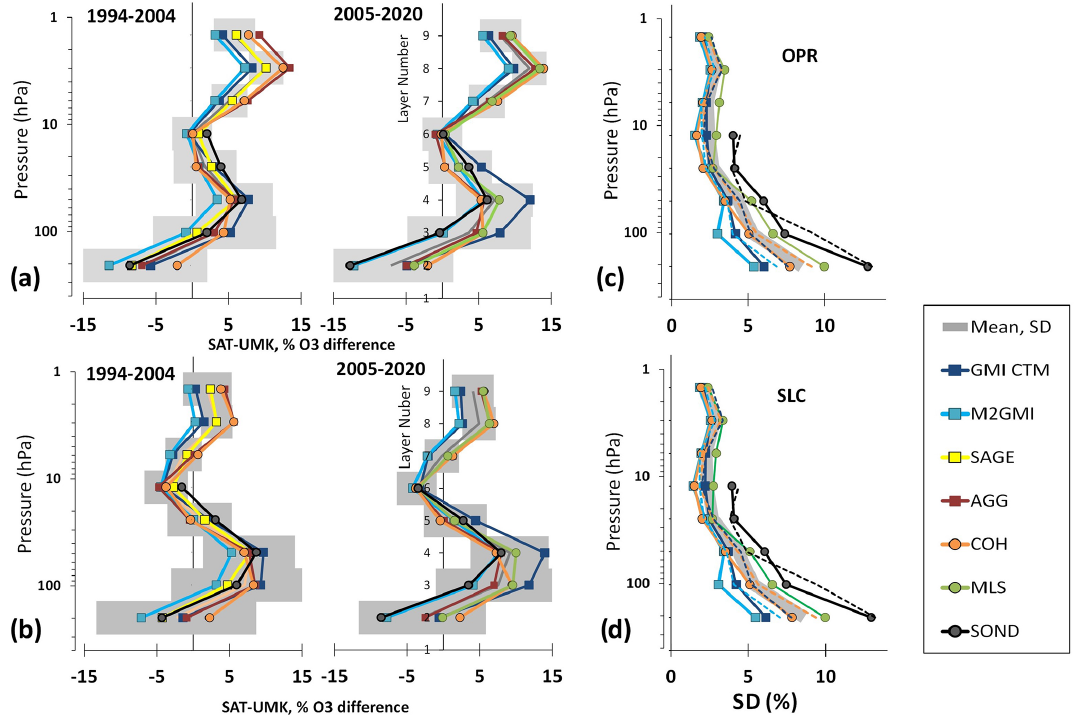
Figure 1. (a) Bias between station overpass data from satellite (AGG, COH, Aura MLS, and SAGE), model profile from grid closest to Boulder geolocation (GMI CTM and M2GMI), ozonesonde record from Boulder relative to operational (OPR) Umkehr profiles taken during 1994–2004 (left panel) and 2005–2020 (right panel). Mean profile and SD are calculated as an average (six sets of comparisons, excluding SAGE) of biases and averaged standard deviations. (b) The same as panel (a) , but Umkehr retrieval includes standard stray light correction (SLC). (c–d) Standard deviations for the mean biases shown in panels (a) and (b) . OPR is operational, and SLC is standard stray light correction. A solid line is for comparisons from 2005 to 2020, and a dotted line is for the 1994–2004 period.